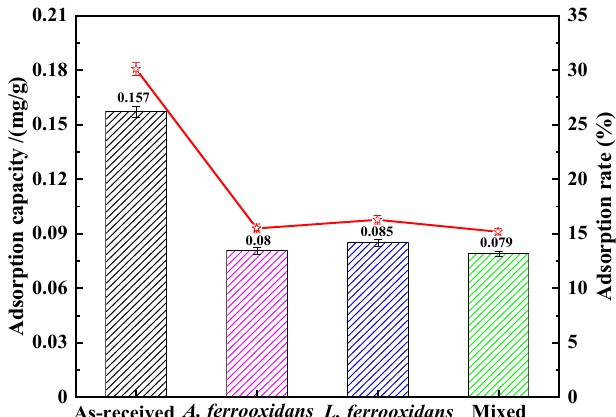
Figure 6. E ff ect of di ff erent treatments on gold adsorption by Figure 6. Effect of different treatments on gold adsorption by DRGO.